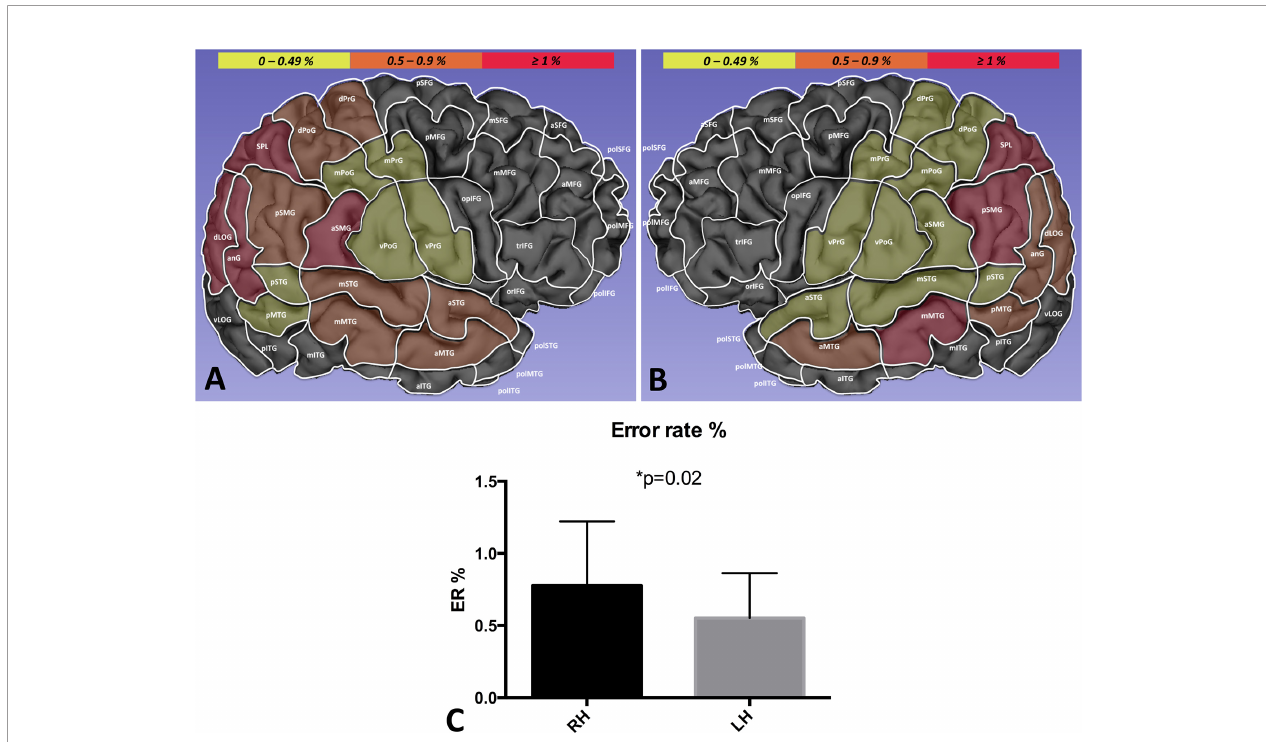
FIGURE 3 | Distribution of the global ER in the right (A) vs. left hemisphere (B) . The ER (%) in each single area is identi fi ed by a growing color intensity (yellow, orange, red). The ER was signi fi cantly higher in the right hemisphere (RH) as compared to the left hemisphere (LH), suggesting a lateralization of VSAs (C)